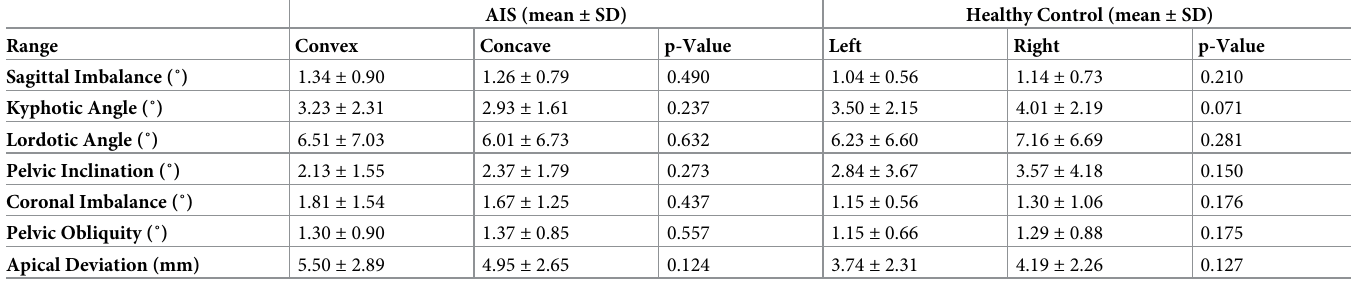
Table 5. Comparison of spinal kinematics between convex-sided with concave-sided shoulder elevation in AIS group and between left and right shoulder elevation in healthy